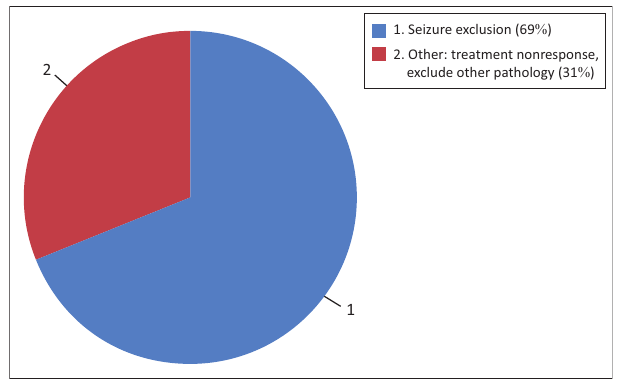
1. Seizure exclusion (69 % ) 2. Other: treatment nonresponse, exclude other pathology (31 %